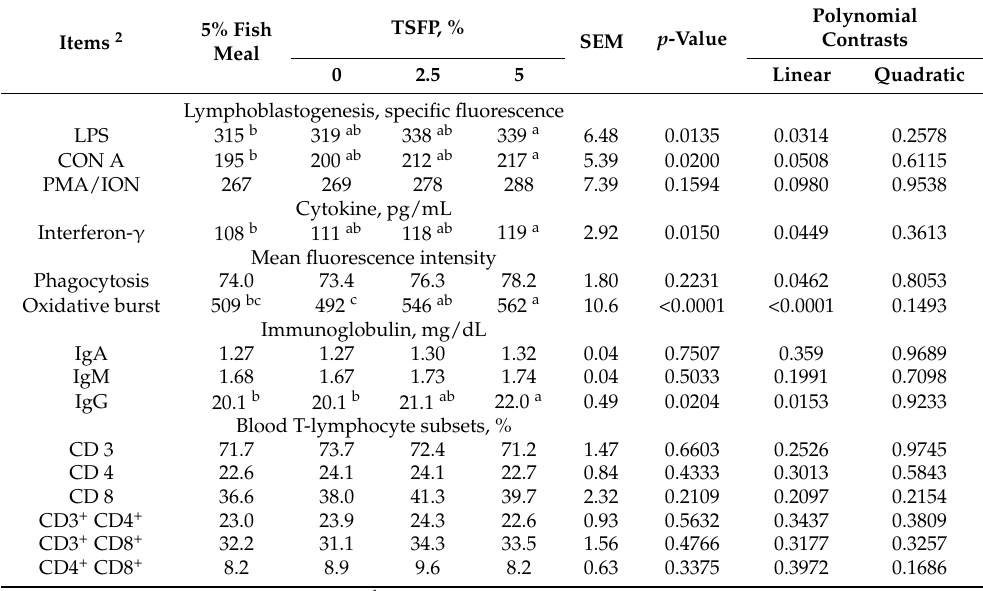
Table 7. Effects of different supplemented levels of TSFP 1 on the immunity of nursery pigs in trial